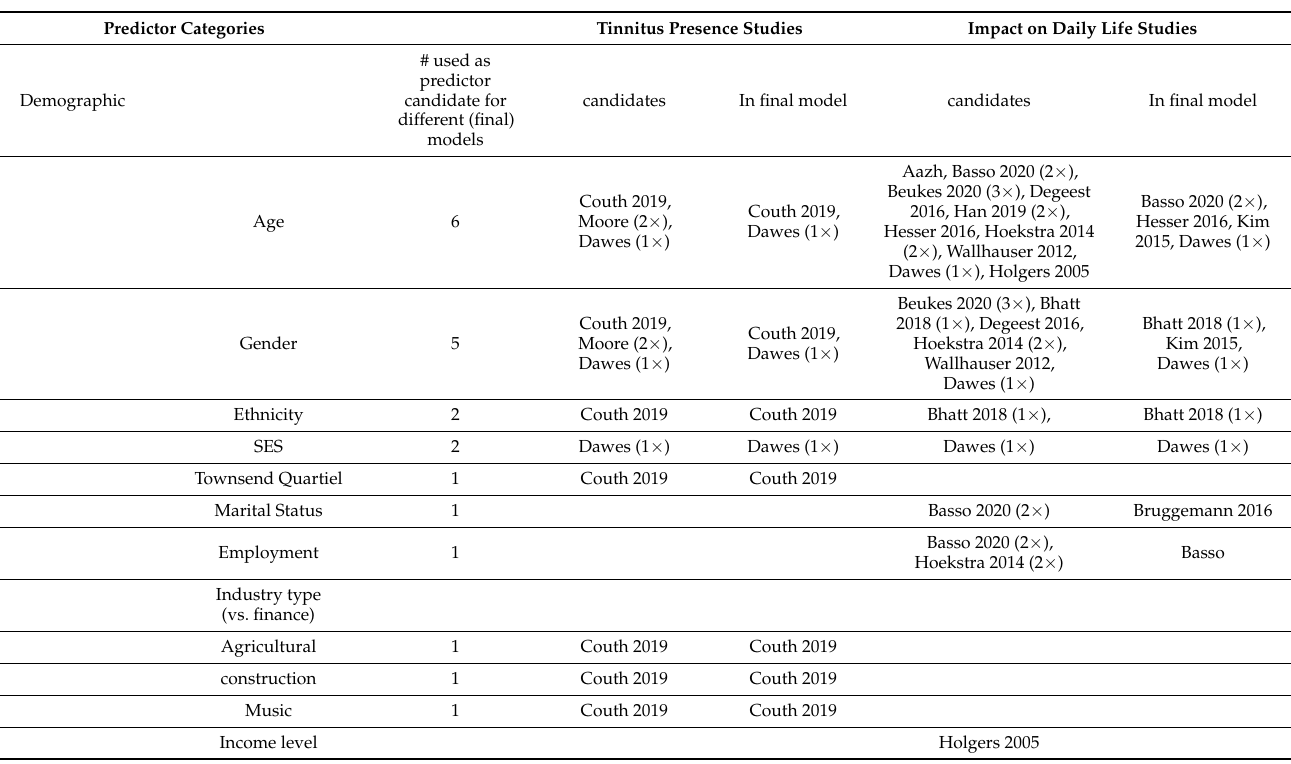
Table A2. Used predictor candidates per